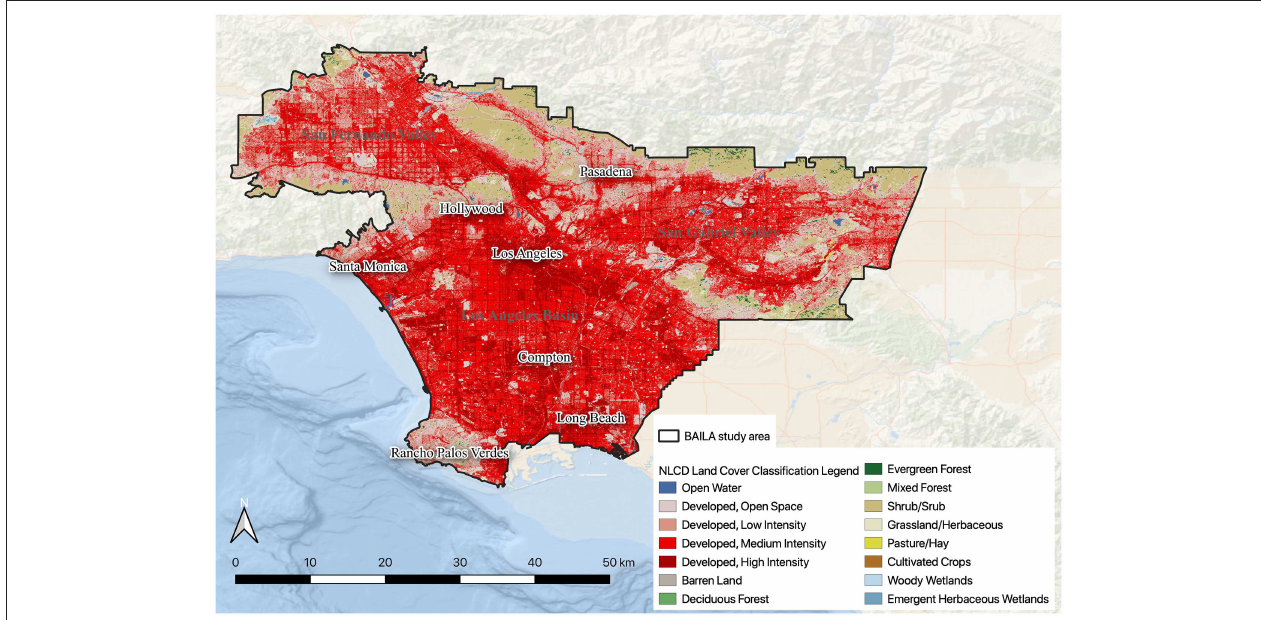
FIGURE 1 | Study area with National Land Cover Data (NLCD) classification demonstrating that much of the study area is developed with only a few NLCD